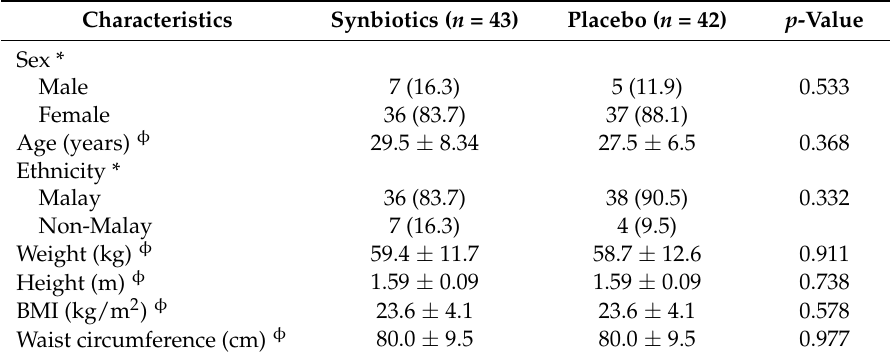
Table 1. Participants’ socio-demography and anthropometric data at baseline.